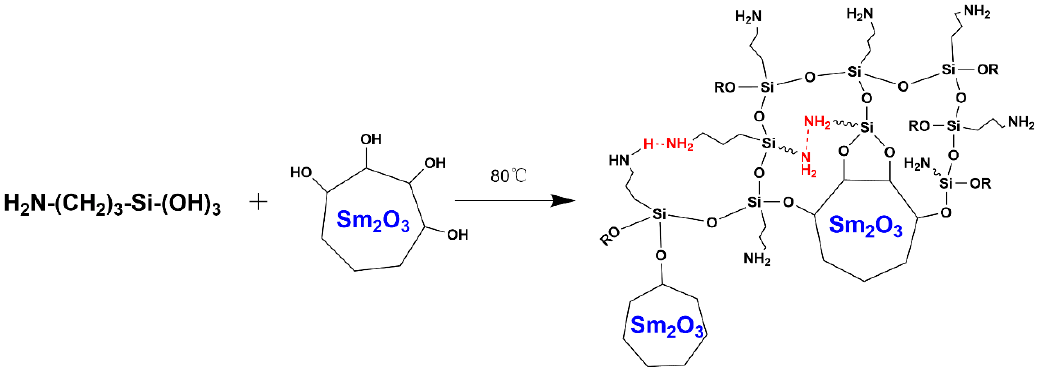
Figure 4. Functional mechanism of APTES on Sm 2 O 3